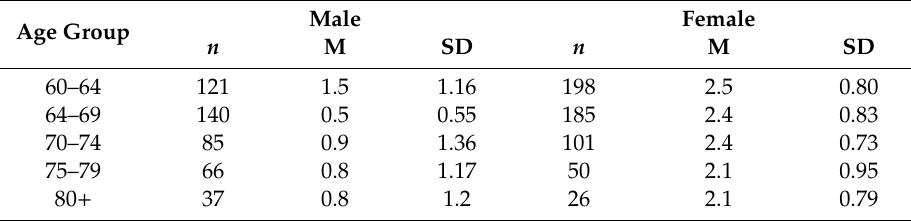
Table 10. Sit and reach based on age group and gender after log transformation. Unit: cm.